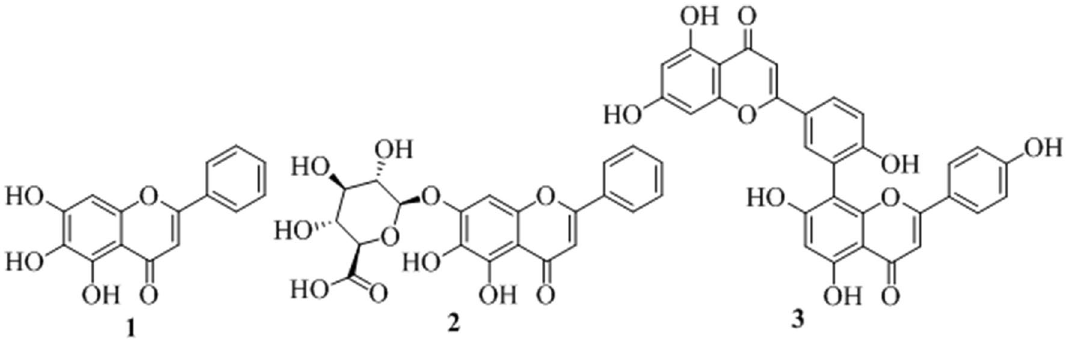
Figure 6. Structures of three known SARS-CoV-2 flavone inhibitors 1 (baicalein), 2 (baicalin) and 3